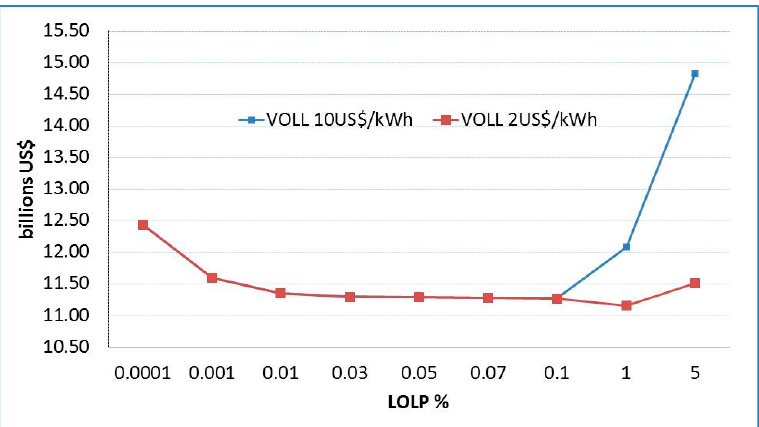
Figure 3. LOLP optimization for two values of lost load (VOLL) levels in the case of a coal-fired thermal power plant (TPP).